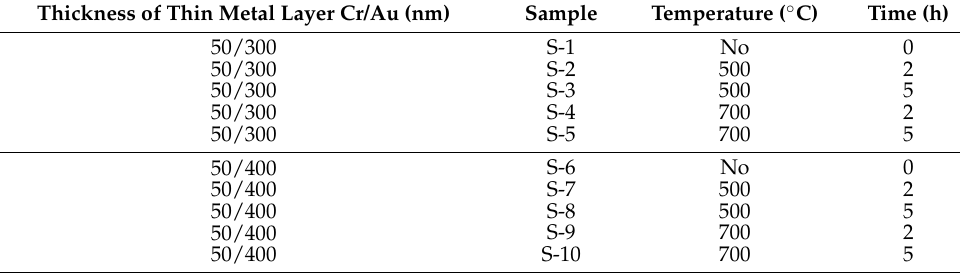
Table 1. Characteristics of experimental samples and experimental environment. Thickness of Thin Metal Layer Cr/Au